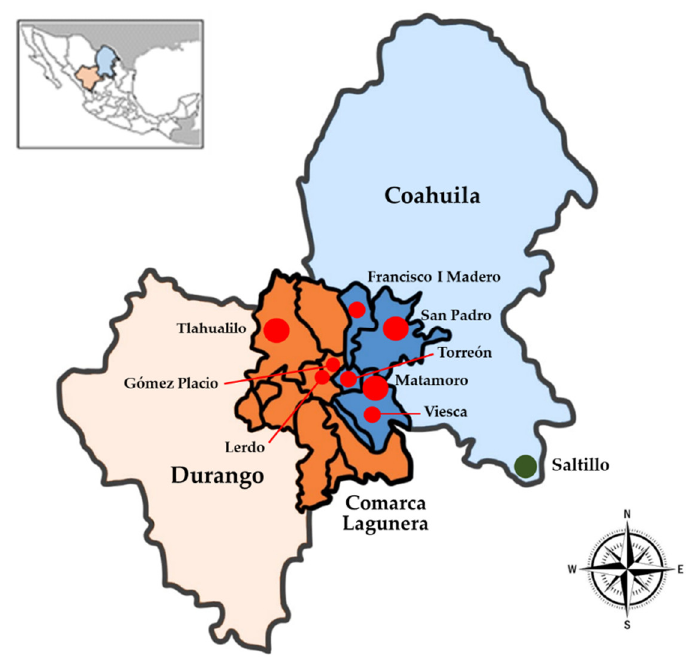
Figure 1. Geographical location of the Comarca Lagunera (CL). Dark orange and blue-colored areas indicate the CL region overlapping the Durango and Coahuila states, respectively. The red dots correspond to the municipalities of the Comarca Lagunera Region (exposed region). The green dot corresponds to the municipality of Saltillo, Coahuila (non-exposed region). Data taken from the National Institute of Statistics and Geography (INEGI, 2019).